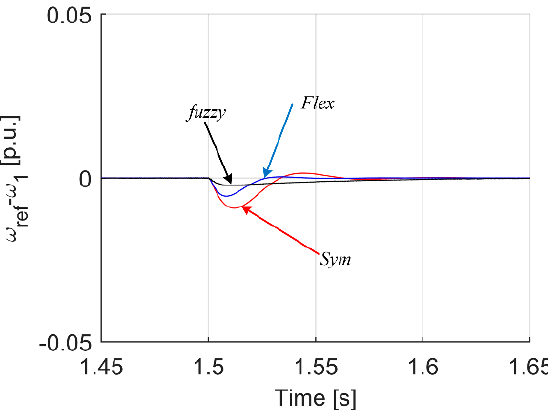
Figure 20. Transients of difference between motor and load speed for analyzed controller cases— zoom.